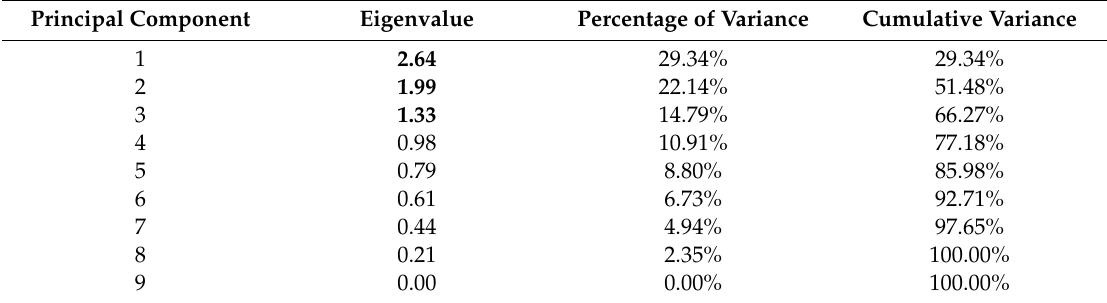
Table 3. Results of principal component analysis comprising 9 variables ( E. coli concentration,